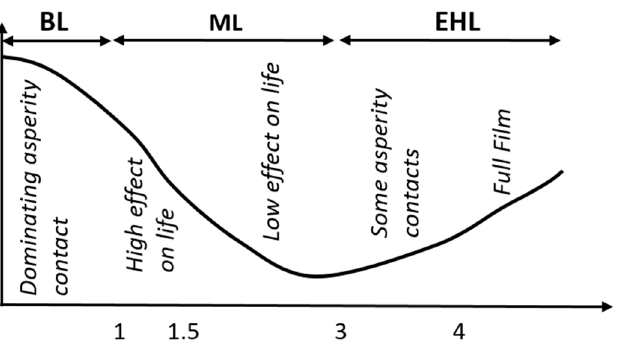
Figure 1. Classification of the lubrication regime based on the lambda ratio. BL, body lubrication; ML, mixed lubrication; EL, elastohydrodynamic lubrication.